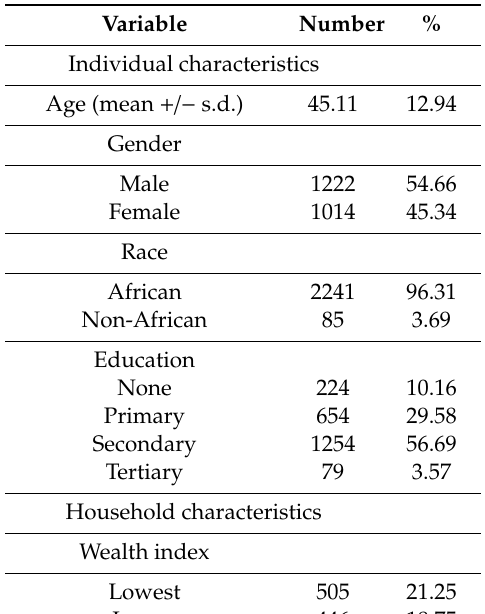
Table 1. Demographic characteristics of study